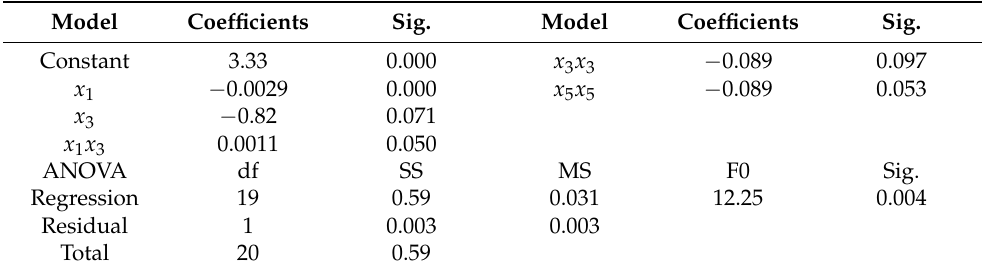
Table 5. Regression analysis and ANOVA for L s .